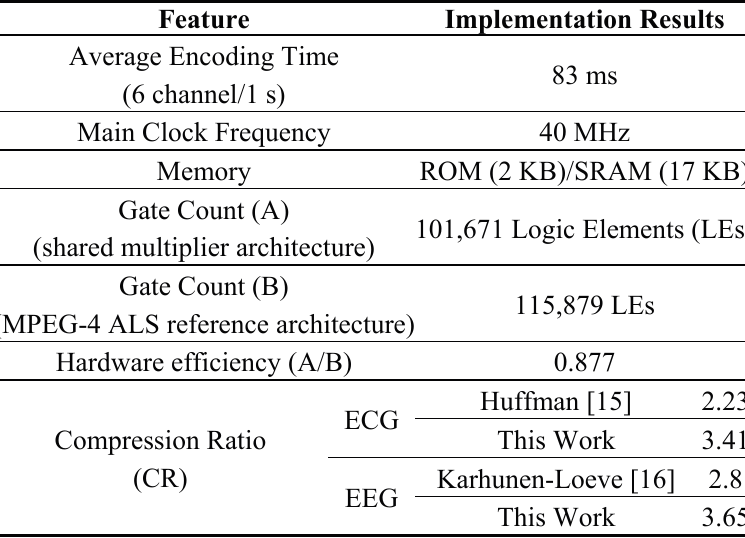
Table 3. Implementation results of the MPEG-4 ALS hardware